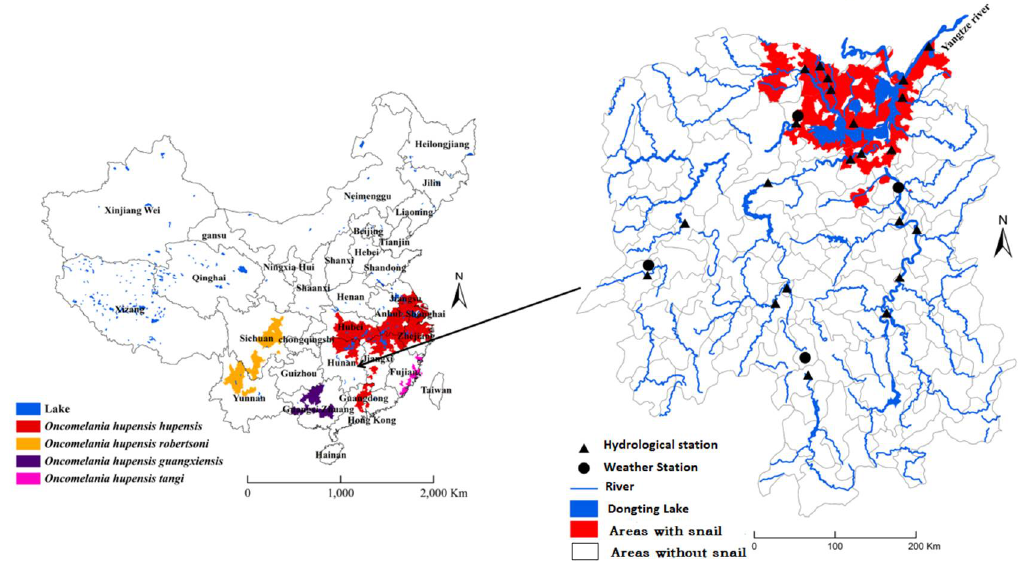
Figure 1. Geographical distribution of O. hupensis in Hunan Province, China.